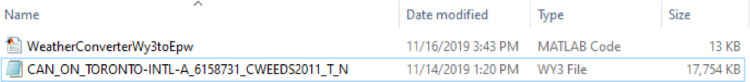
Sample Folder with Script and Weather File to be converted.